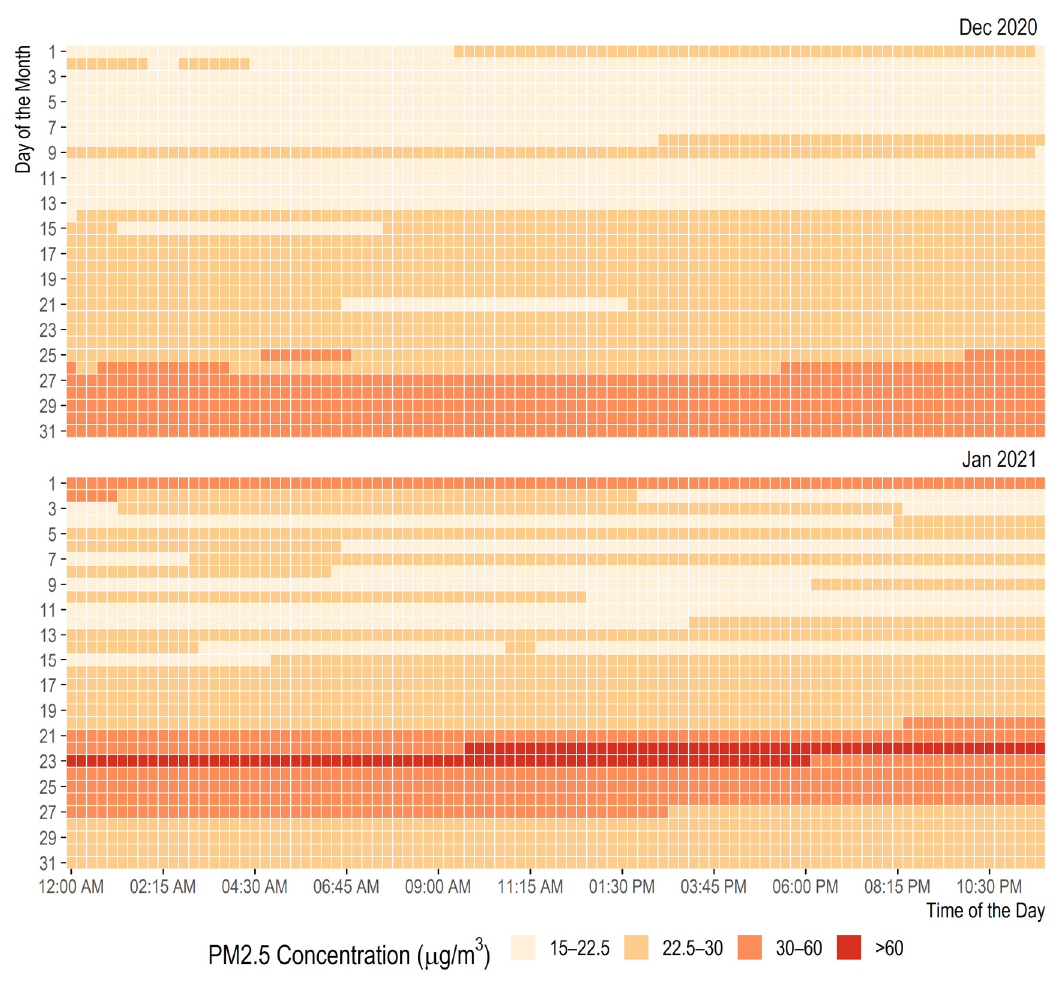
Figure 6. Hourly variation of PM 2.5 concentration profile over the test period.